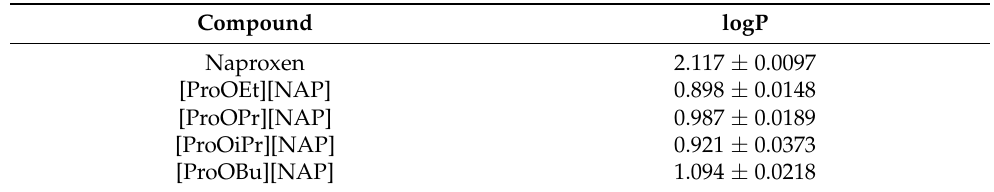
Table 6. The n-octanol-water partition coefficient (log P) of naproxen and L-proline alkyl ester